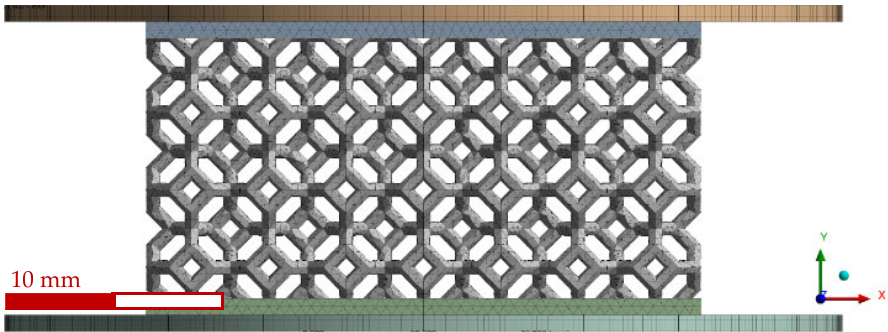
Figure 3. None ‐ graded lattice full mesh with bottom plate and impactor. Figure 3. None-graded lattice full mesh with bottom plate and